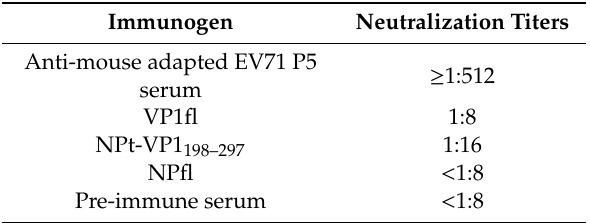
Figure 12. Neutralization analysis of immunized mice sera. Cytopathic e ff ects in Vero cells following a neutralization test. Mixtures of sera dilutions and EV71 strain A104 virus were assayed on Vero cells. The cytopathic e ff ects were examined after seven days of incubation and neutralization titers were determined. ( a ). 1:512 dilution was used for the post-challenge and the positive control sera. ( b ). NPt-VP1 198–297 -immunized samples (1:16 dilution). ( c ). VP1fl-immunized sample with 1:8 titer. ( d , e ). Pre-immune sera and the NPfl-immunized samples barely detectable (1:8 dilution). ( f ). No serum was used in the negative control samples. Magnification = 200X. Table 2. Titers profiles of neutralizing antibody against